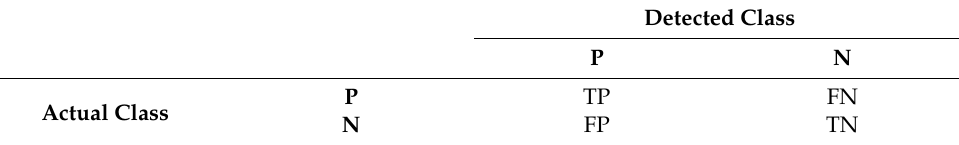
Table 1. The confusion matrix